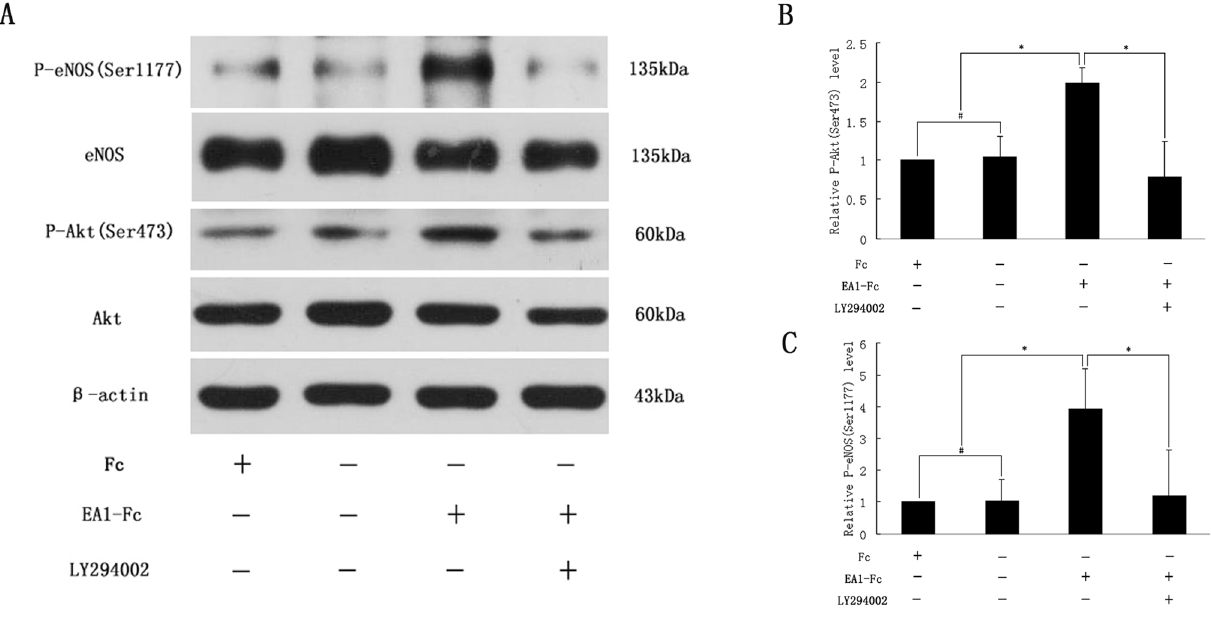
Figure 4. PI3K/Akt mediated ephrin-A1-induced P-eNOS Ser1177 in HUVECs. A: Representative Western blots for P-eNOS Ser1177 and P- Akt Ser473 from HUVECs that were starved in 0.1%BSA EBM-2 overnight and stimulated with ephrin-A1-Fc (1 m g/ml) for 30 min alone or together pre- treated with LY294002. B: Quantity analysis of P-Akt Ser473 . C: Quantity analysis of P-eNOS Ser1177 . (*, P , 0.05, n=4) ( # , P . 0.05,